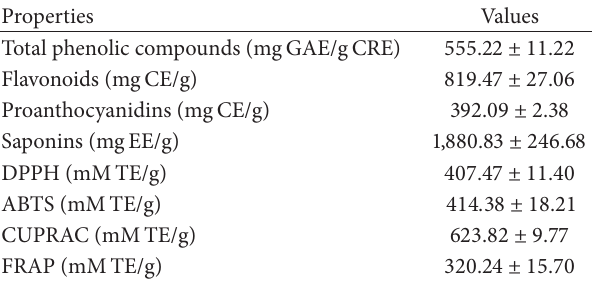
Table1:Physicochemicalandantioxidantpropertiesoftheenriched extract prepared by optimal solvent.